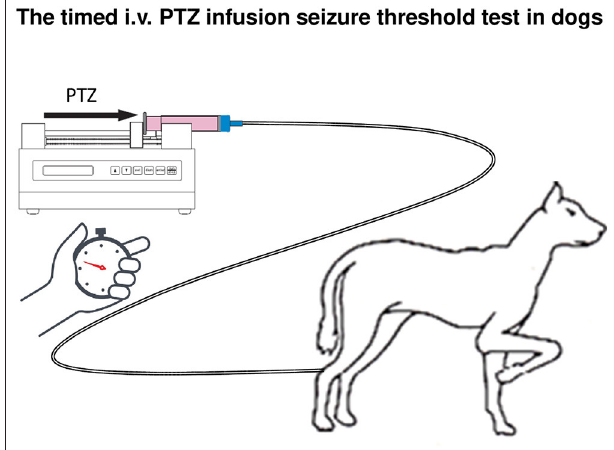
FIGURE 5 | Schematic illustration of the timed i.v. pentylenetetrazol (PTZ) seizure threshold test in an unrestrained dog. Before beginning the experiments, it is important to habituate the dogs to persons involved in the experiments as well as to the rooms and to handling. For seizure threshold determination, a 3% solution of PTZ (in 0.9% NaCl) is continuously infused at a rate of 3 ml/min by an infusion pump via a thin, flexible plastic catheter of about 1m length, connected by a sharp cut-off end of an injection needle to the cephalic vein at a hind leg. The infusion is terminated immediately after the occurrence of the first generalized twitch (initial myoclonus), which usually takes on average 120s after the onset of PTZ infusion. Before the myoclonic twitch, dogs typically exhibit tremors as a sign of increasing neuronal excitability. During PTZ infusion, the animal is only slightly restricted (or, in trained dogs, not restricted at all). The threshold dose of PTZ (in mg/kg body weight) is calculated from the infusion rate, the bodyweight of the animal, and the time necessary to produce the first myoclonic twitch (which occurs together with the first paroxysmal EEG activity). Typical PTZ seizure thresholds are in the range of ∼ 15 mg/kg PTZ but may vary with the breed, sex, and age of the dogs. The potency of drugs to increase seizure threshold can be determined (and compared) by calculating the doses required to increase the threshold by 20% (TID 20 ) or 50% (TID 50 ), testing a range of doses in groups of dogs (see Figure 7 ). The same dogs can be repeatedly used at intervals of at least 1 week to avoid kindling (see text). Dogs rapidly adapt to the method and do not show any signs of discomfort or anxiety before or after the threshold determination. Before any drug experiments, the PTZ seizure threshold is determined once per week until reproducible and stable thresholds are obtained in all dogs. The figure was modified from Löscher ( 269). For details see Löscher et al.